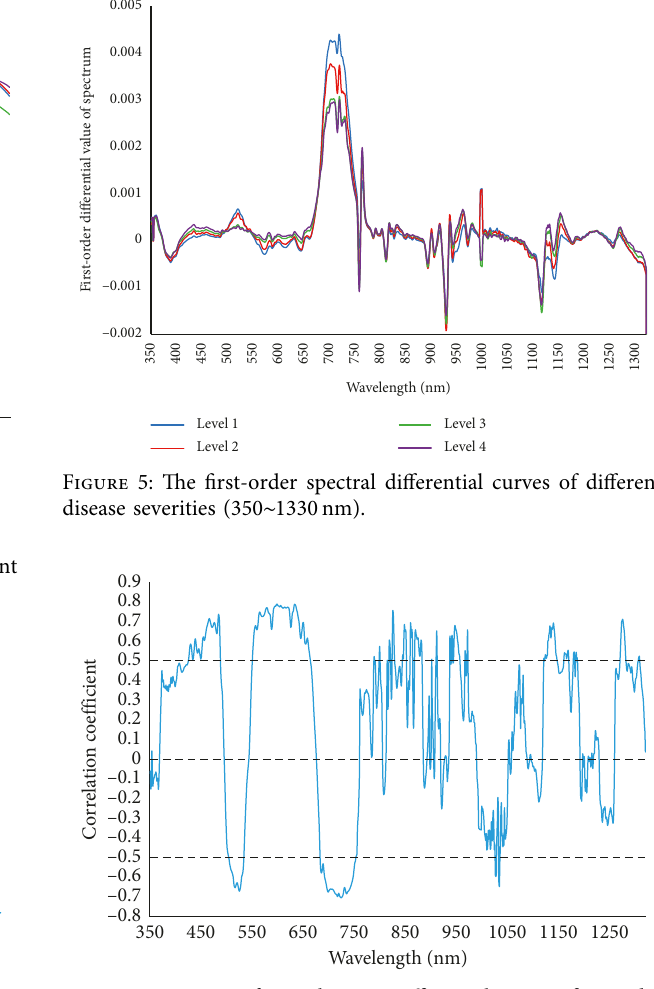
Figure 6: Curves of correlation coefficient between first-order differential spectrum and disease